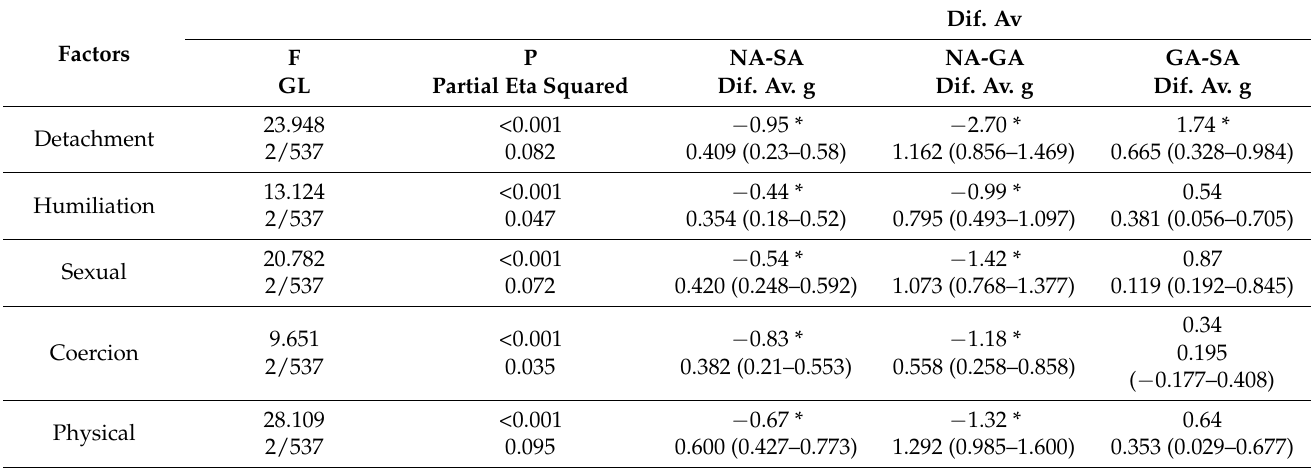
Table 7. Analysis of MANOVA on the differential effect of the typology of the self-perception of abuse in each of the considered factors of